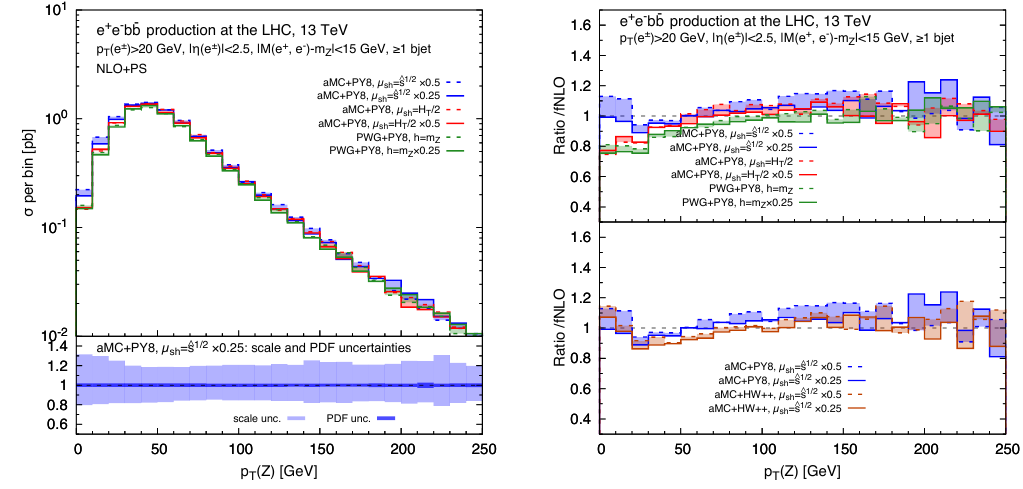
Figure 17 . p ‘ + ‘ (cid:0) distribution in association with at least 1 b jet. ?